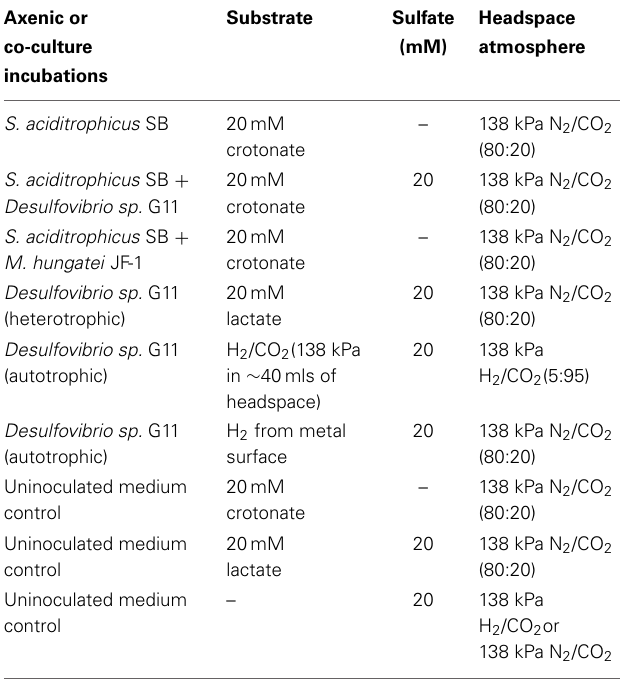
Table 2 | Substrate, sulfate, and headspace amendments for fatty acid oxidizing incubations.